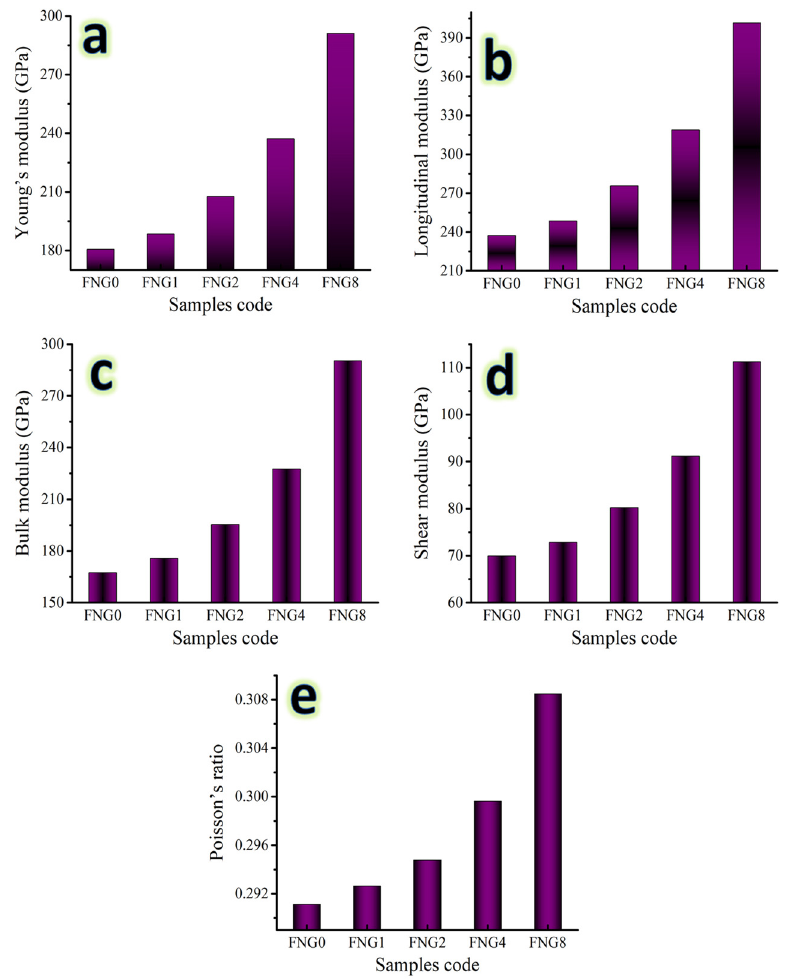
Figure 12. The group of elastic moduli of various sintered samples in terms of ( a ) Young’s modulus, ( b ) longitudinal modulus, ( c ) bulk modulus, ( d ) shear modulus and ( e ) Poisson’s ratio.